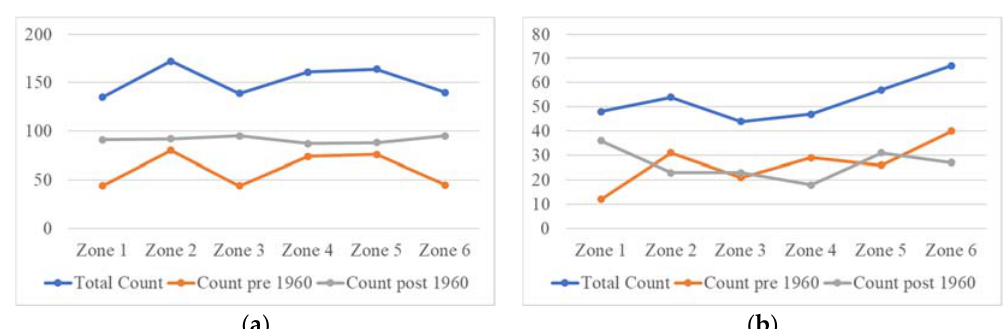
Figure 15. ( a ) 3-month and ( b ) 12-month SPEI drought Figure 15. ( a ) 3 ‐ month and ( b ) 12 ‐ month SPEI drought counts.